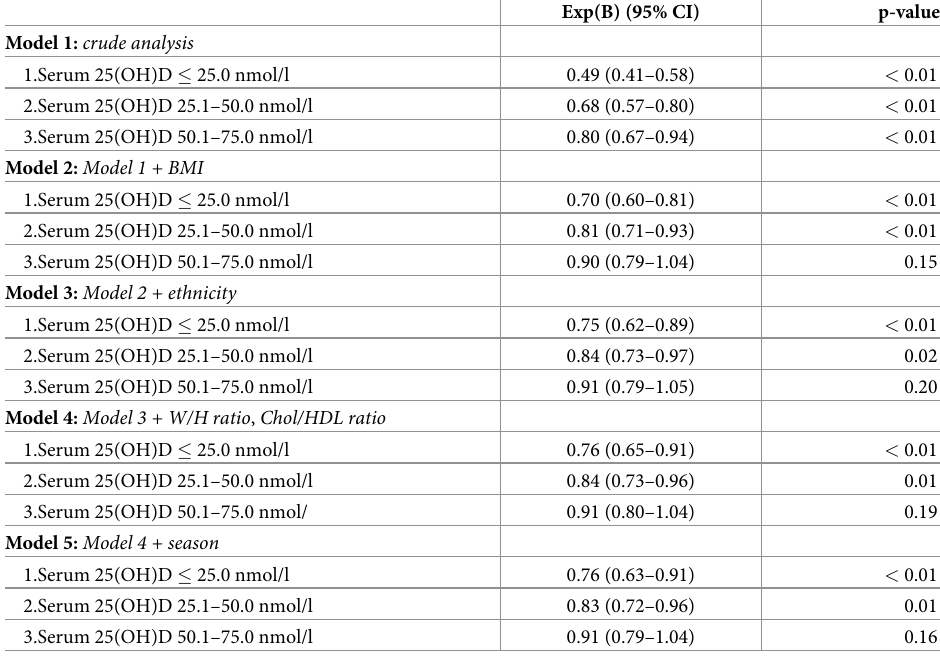
Table 4. Linear regression analysis of vitamin D groups � and HOMA-IR ��